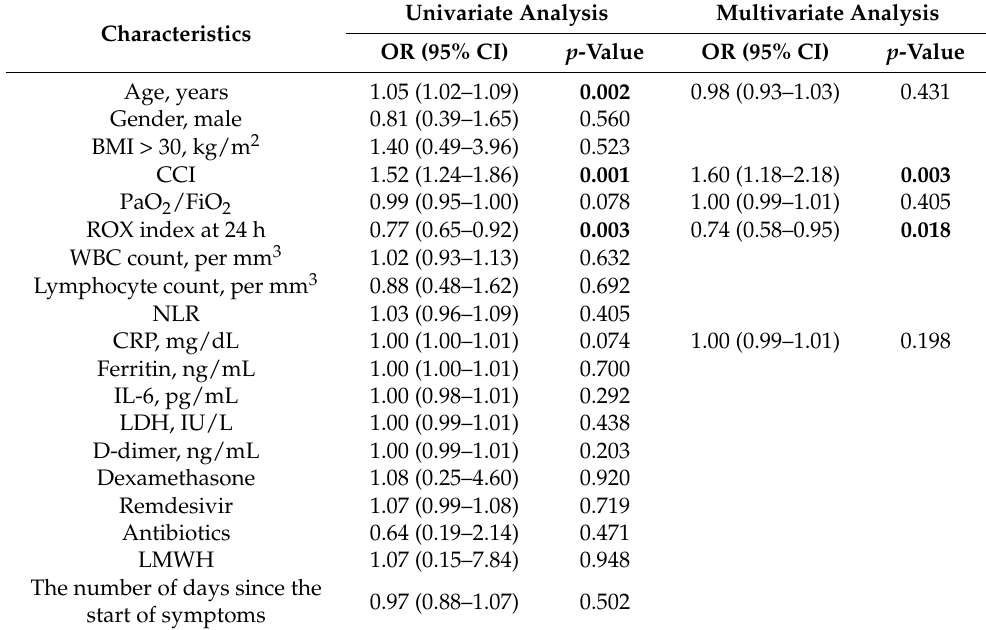
Table 2. HFNC failure predictors.